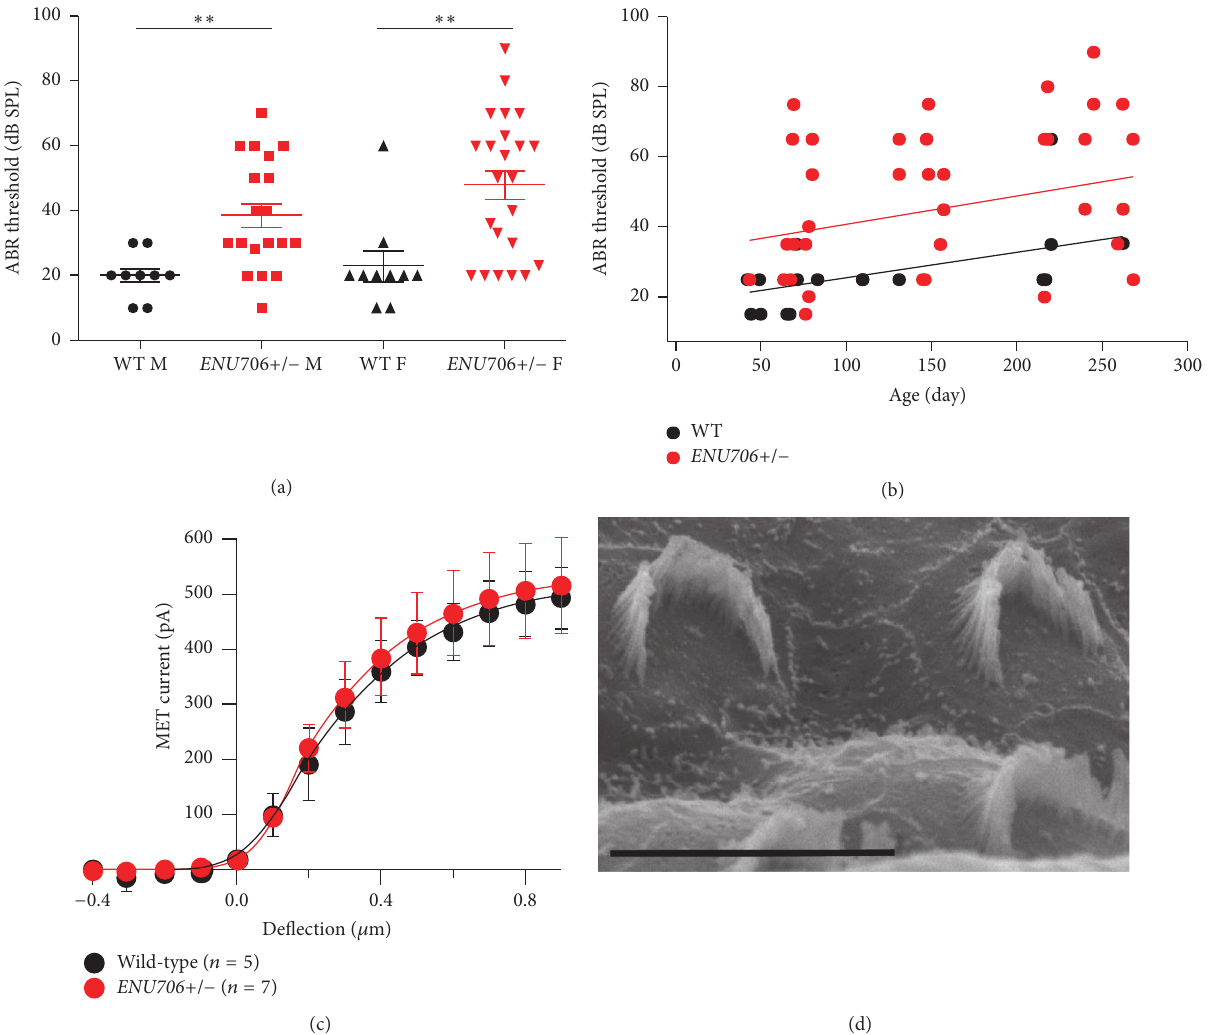
Figure 3: The ENU706 mice had no obvious defects in hair cell mechanotransduction. (a) The ABR threshold was box-whisker plotted in 4 categories: wild-type male (WT M, 20.0 ± 2.4 dB SPL, 8 males tested, 8 right ears plus 1 left ear), heterozygous male ( ENU706 +/ − M, 38.7 ± 3.9 dB SPL, 11 males tested, 11 right ears, and 8 left ears), wild-type female (WT F, 23.0 ± 4.5 dB SPL, 8 females tested, 9 right ears, and 1 left ear), and heterozygous female ( ENU706 +/ − F, 47.9 ± 4.5 dB SPL, 13 females tested, 13 right ears, and 10 left ears). The “ 𝑛 ” numbers